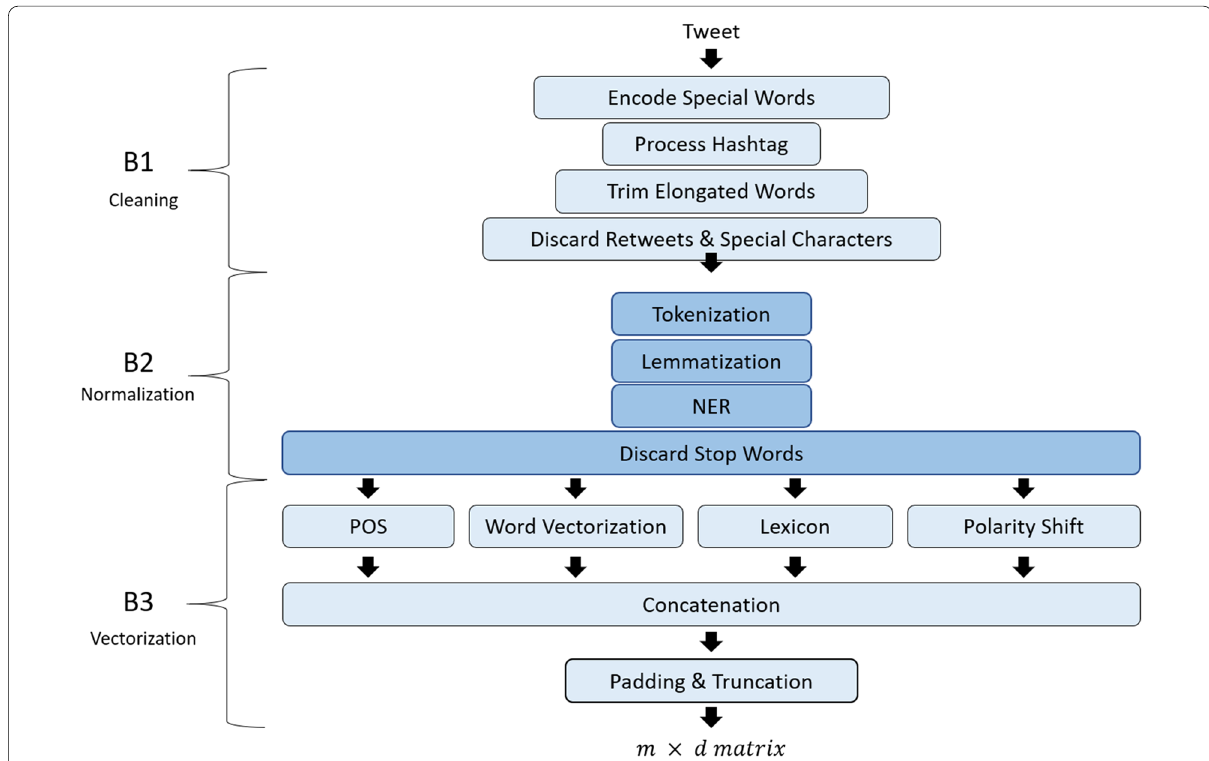
Fig. 2 Diagram illustrating the preprocessing pipeline